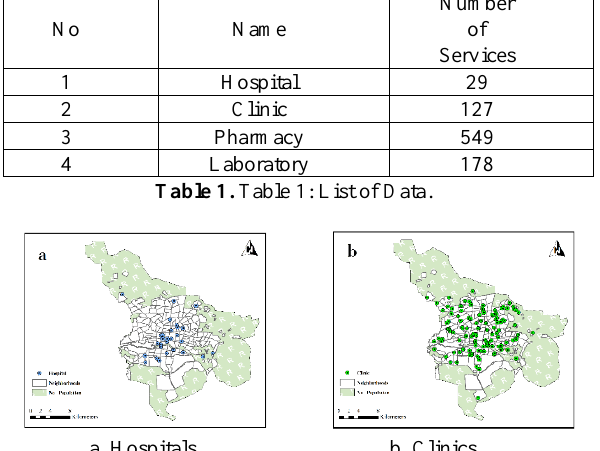
Figure 1. Map of Isfahan Metropolitan Area in Iran. Figure 2. is the population density of Isfahan and the 15 official administrative districts of the city. This map shows that the population distribution in the city is geographically uneven, and the density of the population is higher in districts close to the historical core of the city.